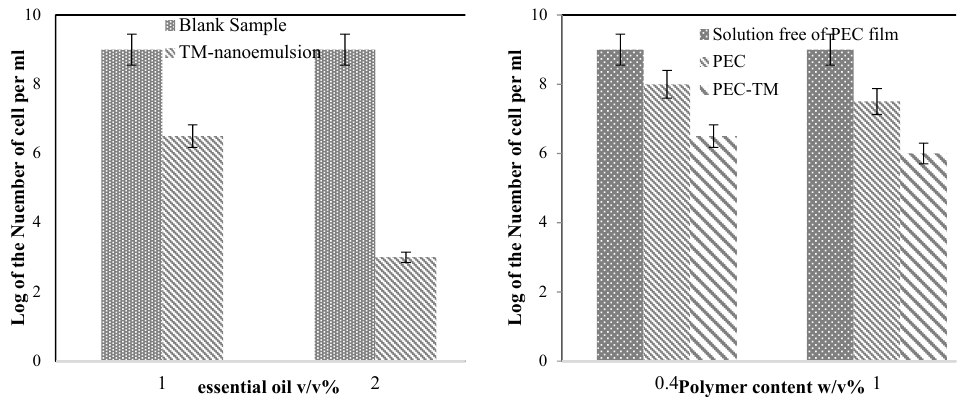
Figure 8. Antibacterial activities of TM-PEC films and TM-nanoemulsions against S.aureus .